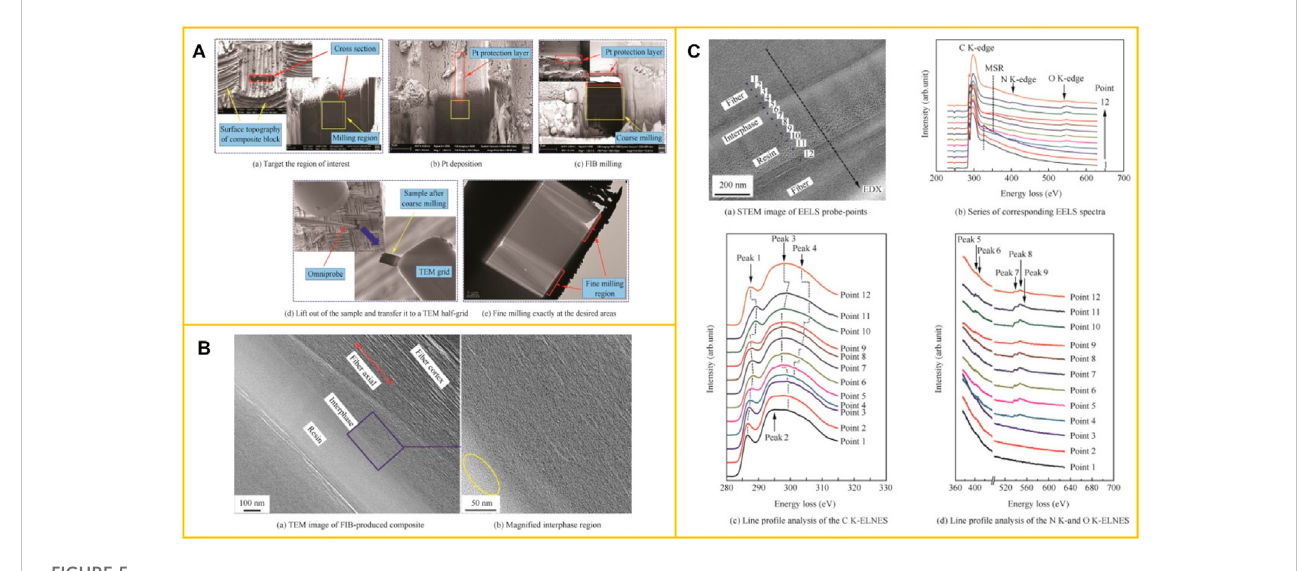
FIGURE 5 (A) Series of SEM images visualizing the sample preparation process by FIB of T300/epoxy composite longitudinal direction. Reprinted with permission from(Wuetal.,2015).Copyright2015ElsevierB.V. (B) TheTEMimageoftheFIB-produced compositeshowsthreeregions: fi ber,interphase,andepoxyresin. Reprintedwithpermissionfrom(Wuetal.,2015).Copyright2015ElsevierB.V. (C) EELSspectraanalysisoftheinterphaseregionintheenergylossrangeofCK- , N K-, and O K-edges. Reprinted with permission from (Wu et al., 2015). Copyright 2015 Elsevier